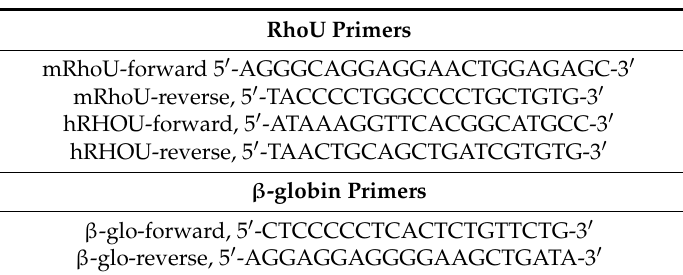
Table 1. Primers used for